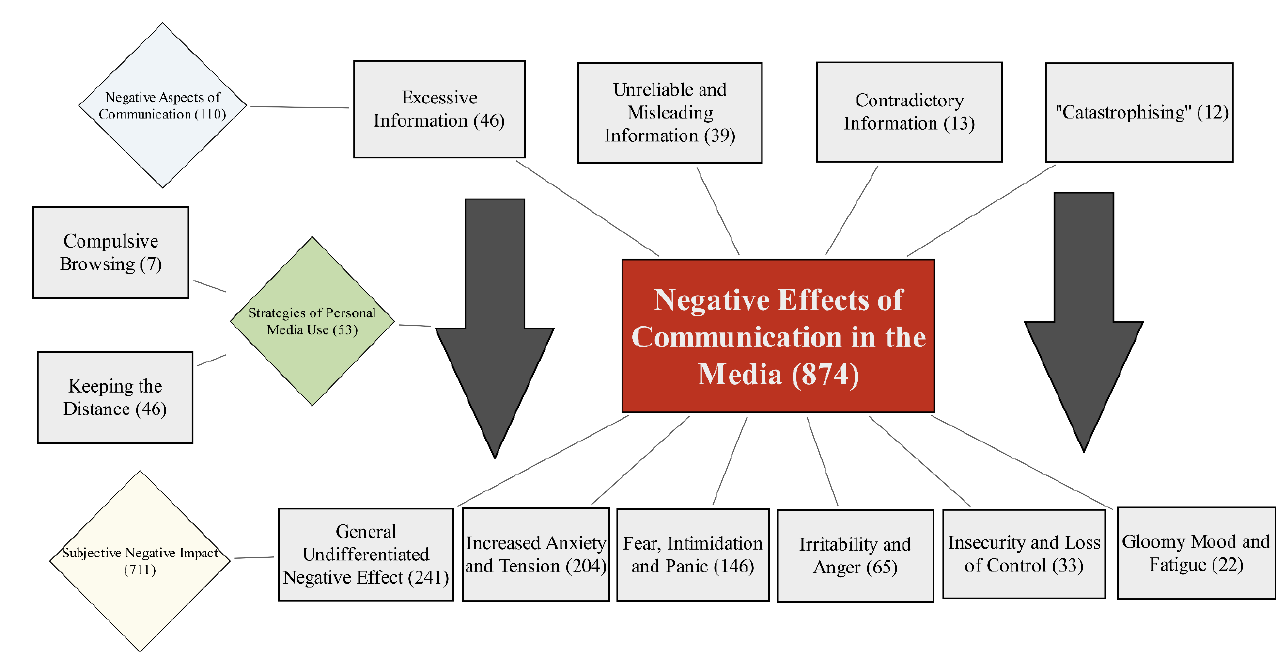
Figure 1. Thematic Model: Negative Effects of Communication in the Media.